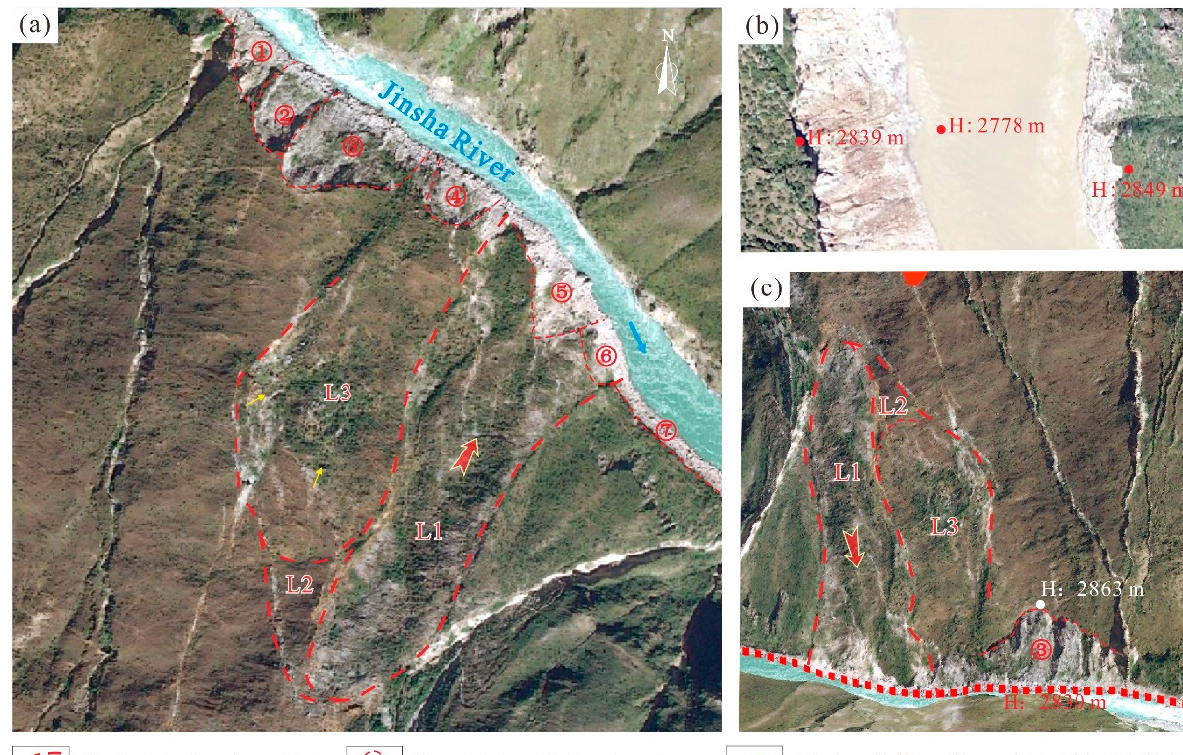
Figure 9. Typical profile of the InSAR deformation rate of the Xiongba ancient landslide. ( a ) Deformation rate profile of the H1 deformable body; ( b ) deformation rate profile of the H2 deformable body.